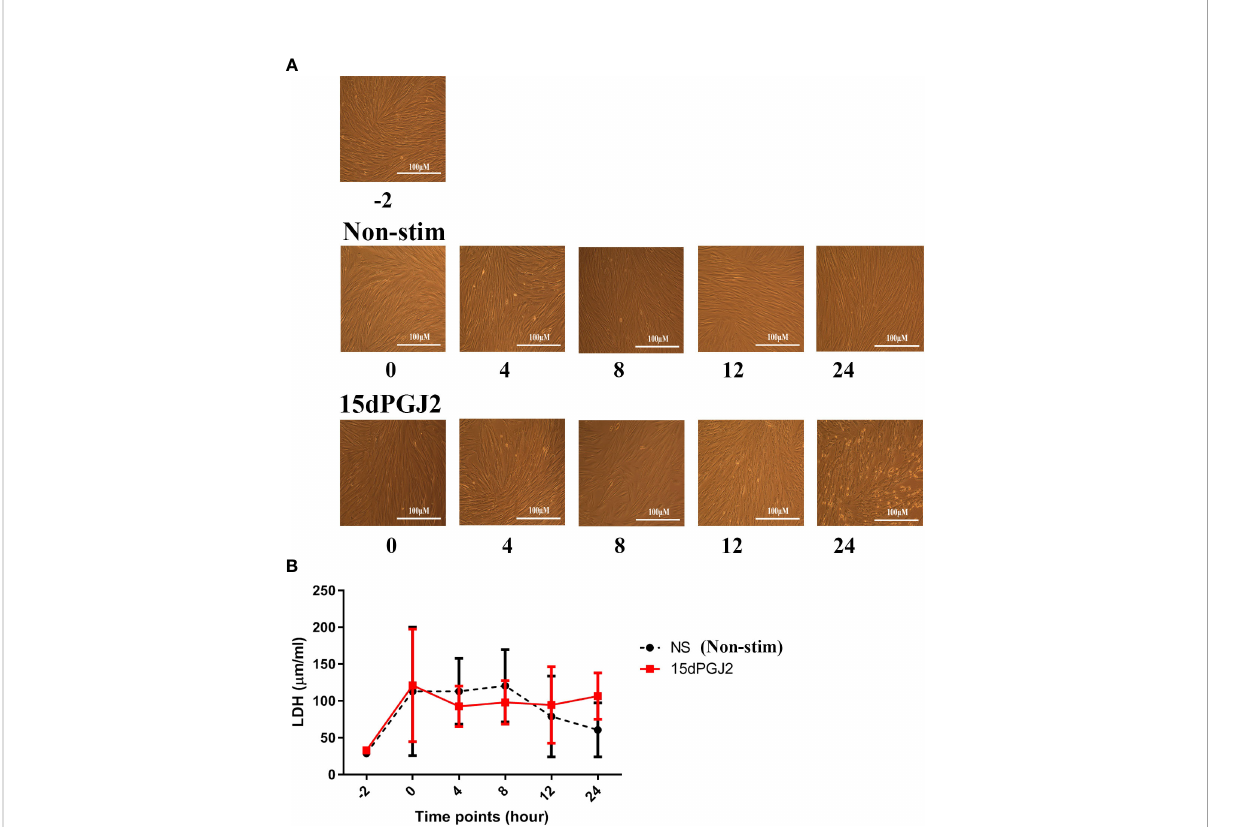
FIGURE 5 15dPGJ2 effects on myometrial cells integrity. Myometrial cells were pre-incubated with 32µM of 15dPGJ2 or vehicle for 2 hours and assessed for 24 hours. Morphology of the cells were assessed by bright fi eld microscopy (A) and LDH release into supernatant was detected at -2, 0, 4, 8, 12 and 24 hours (B) . No difference in LDH release was seen between timepoints or between vehicle control and 15dPGJ2 treated cells. n = 3. Data are presented as mean ± SEM. NS,